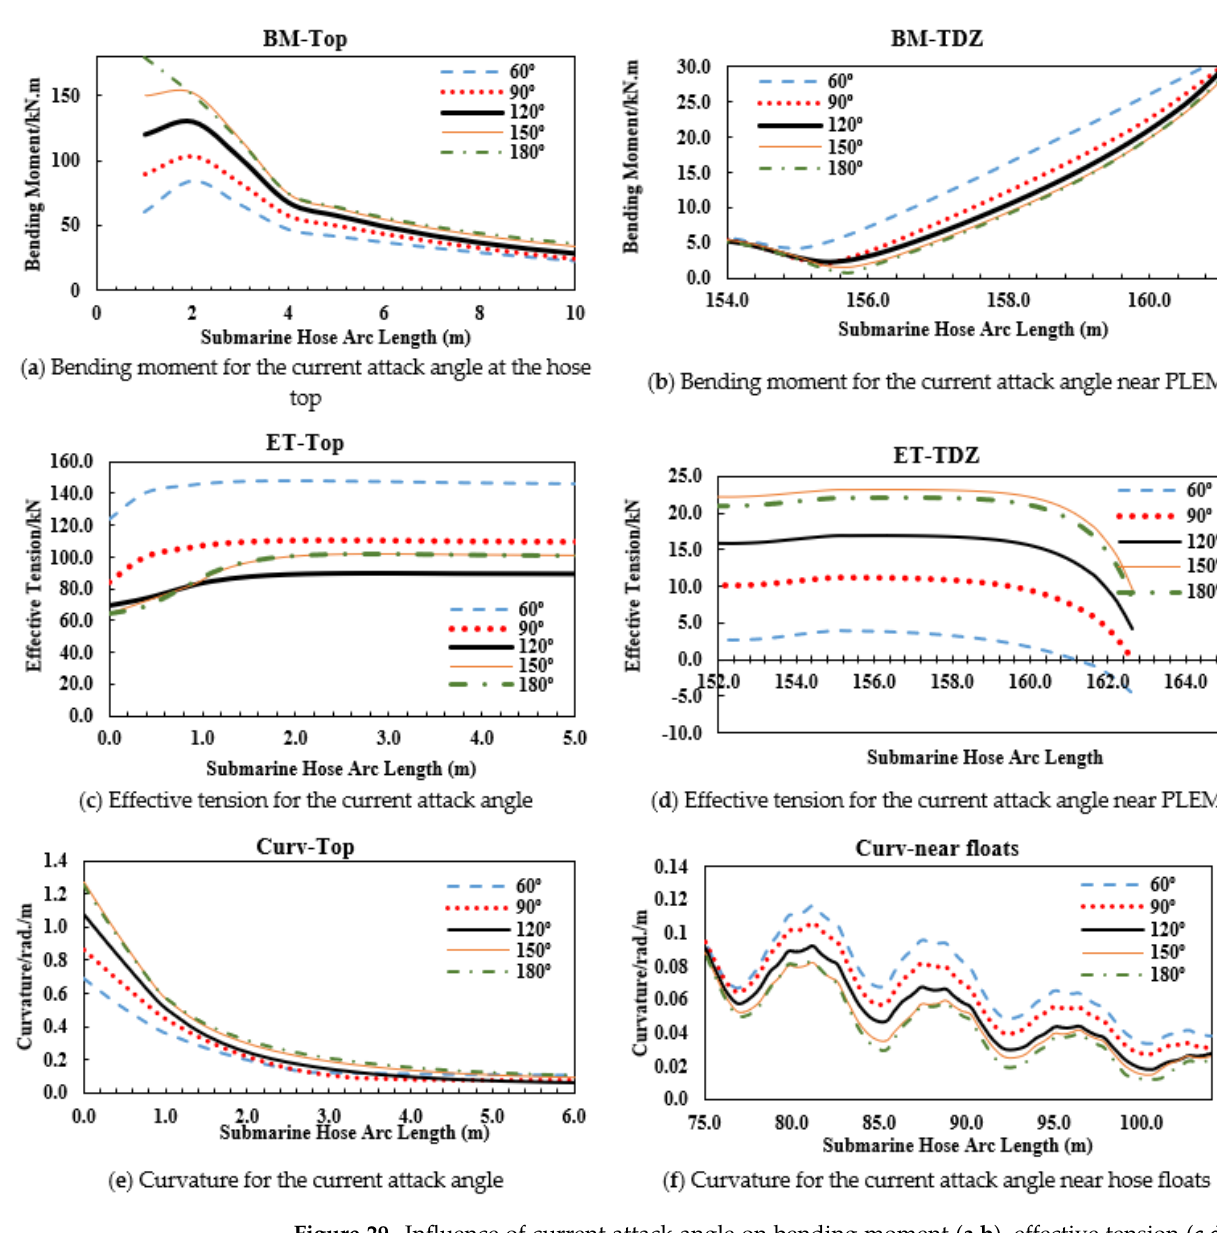
Figure 29. Influence of current attack angle on bending moment ( a , b ), effective tension ( c , d ) and curvature ( e , f ) on hose.